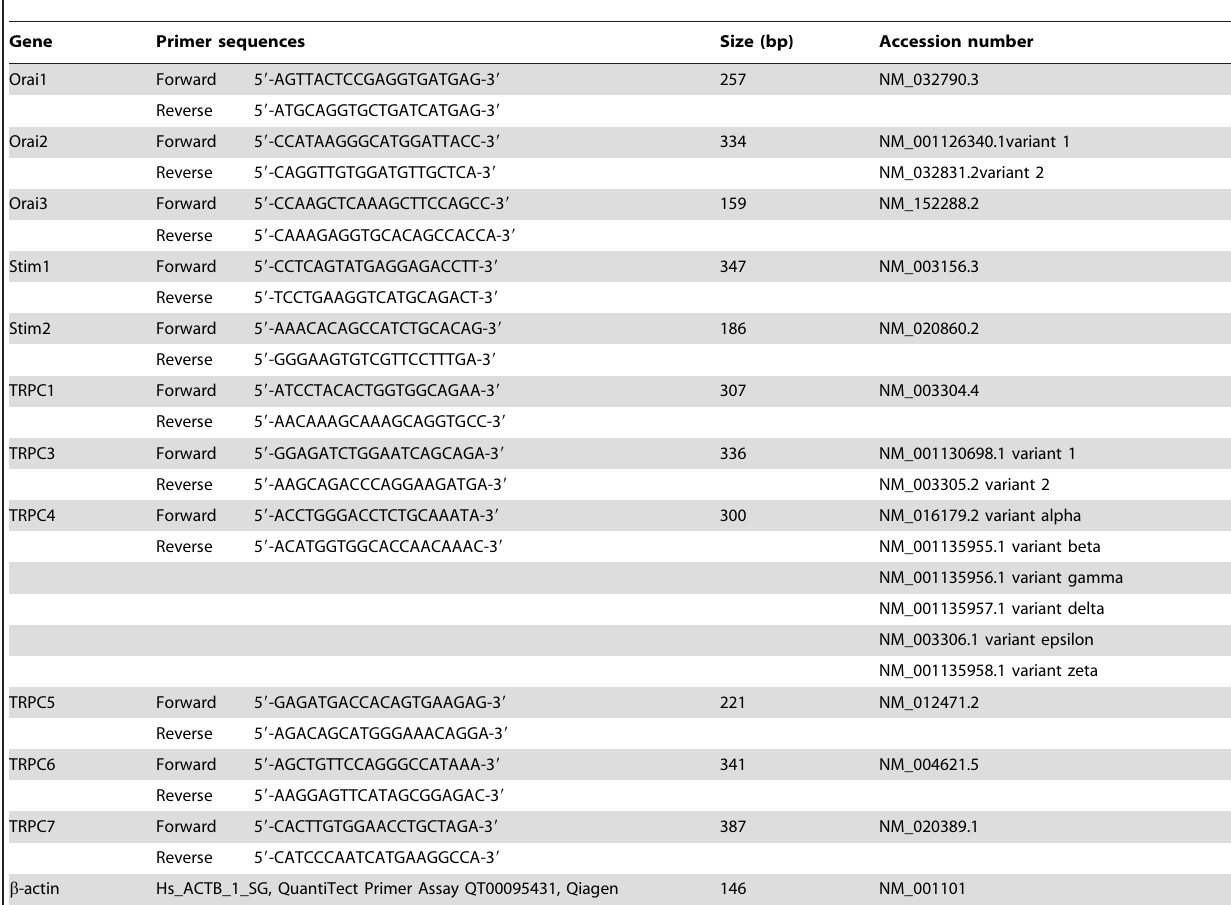
Table 2. Primer sequences used for real time reverse transcription/polymerase chain reaction of Orai1-3, Stim1-2, TRPC1-7.